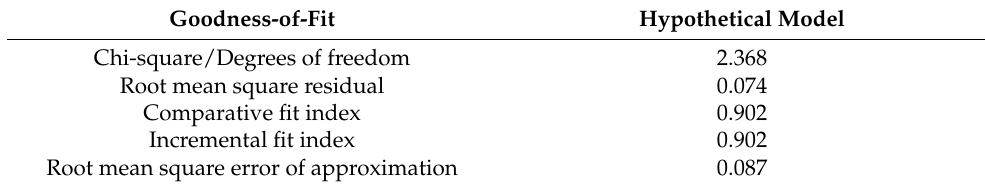
Table 3. Confirmatory factor analysis for the proposed model, verification of goodness-of-fit.